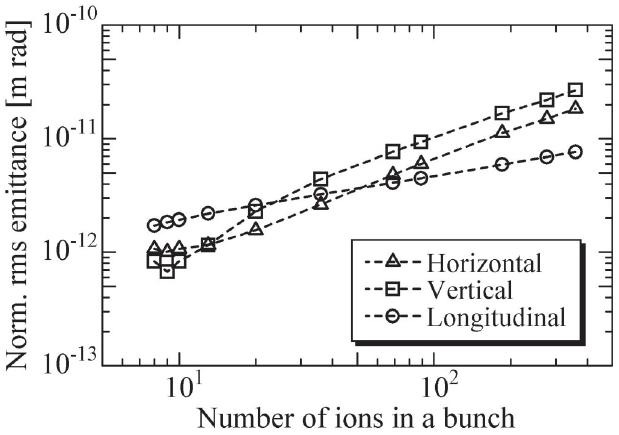
FIG. 13. Final normalized rms emittances of laser-cooled beams vs the number of ions in a bunch.